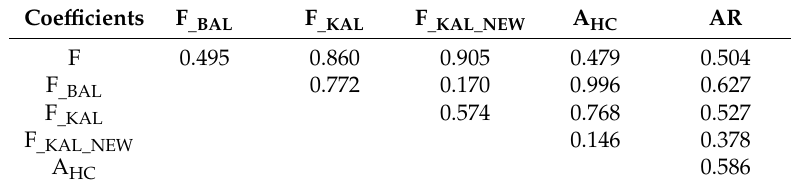
Table 4. Correlation among di ff erent inbreeding coe ffi cients and average relatedness.